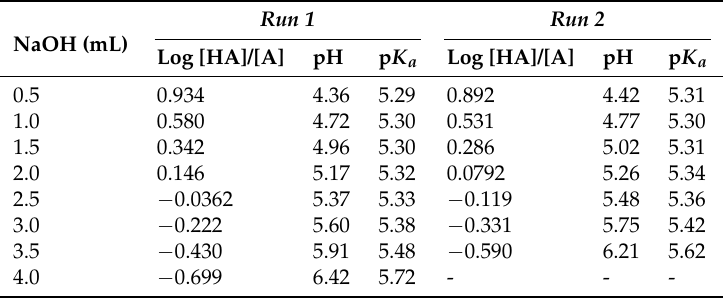
Table 6. Calculations of the acidity constants of 1 (Table 1), according to the results of two titrations. p K a = 5.39 and 5.38 as the arithmetic mean of all eight values in the set Run 1 and Run 2 , respectively. Run 1 Run 2 NaOH